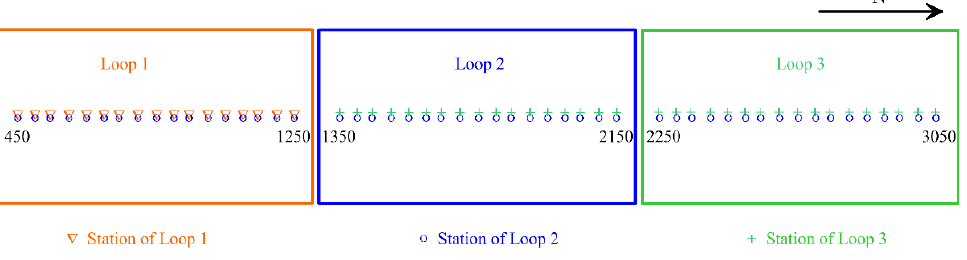
Figure 7. Schematic diagram of transmitting loops and TEM stations. Table 5. Parameters of field data